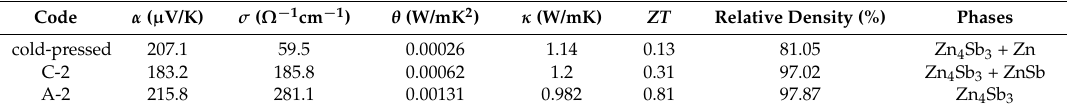
Table 2. Thermoelectric properties of Zn 4 Sb 3 bulk specimens measured at 600